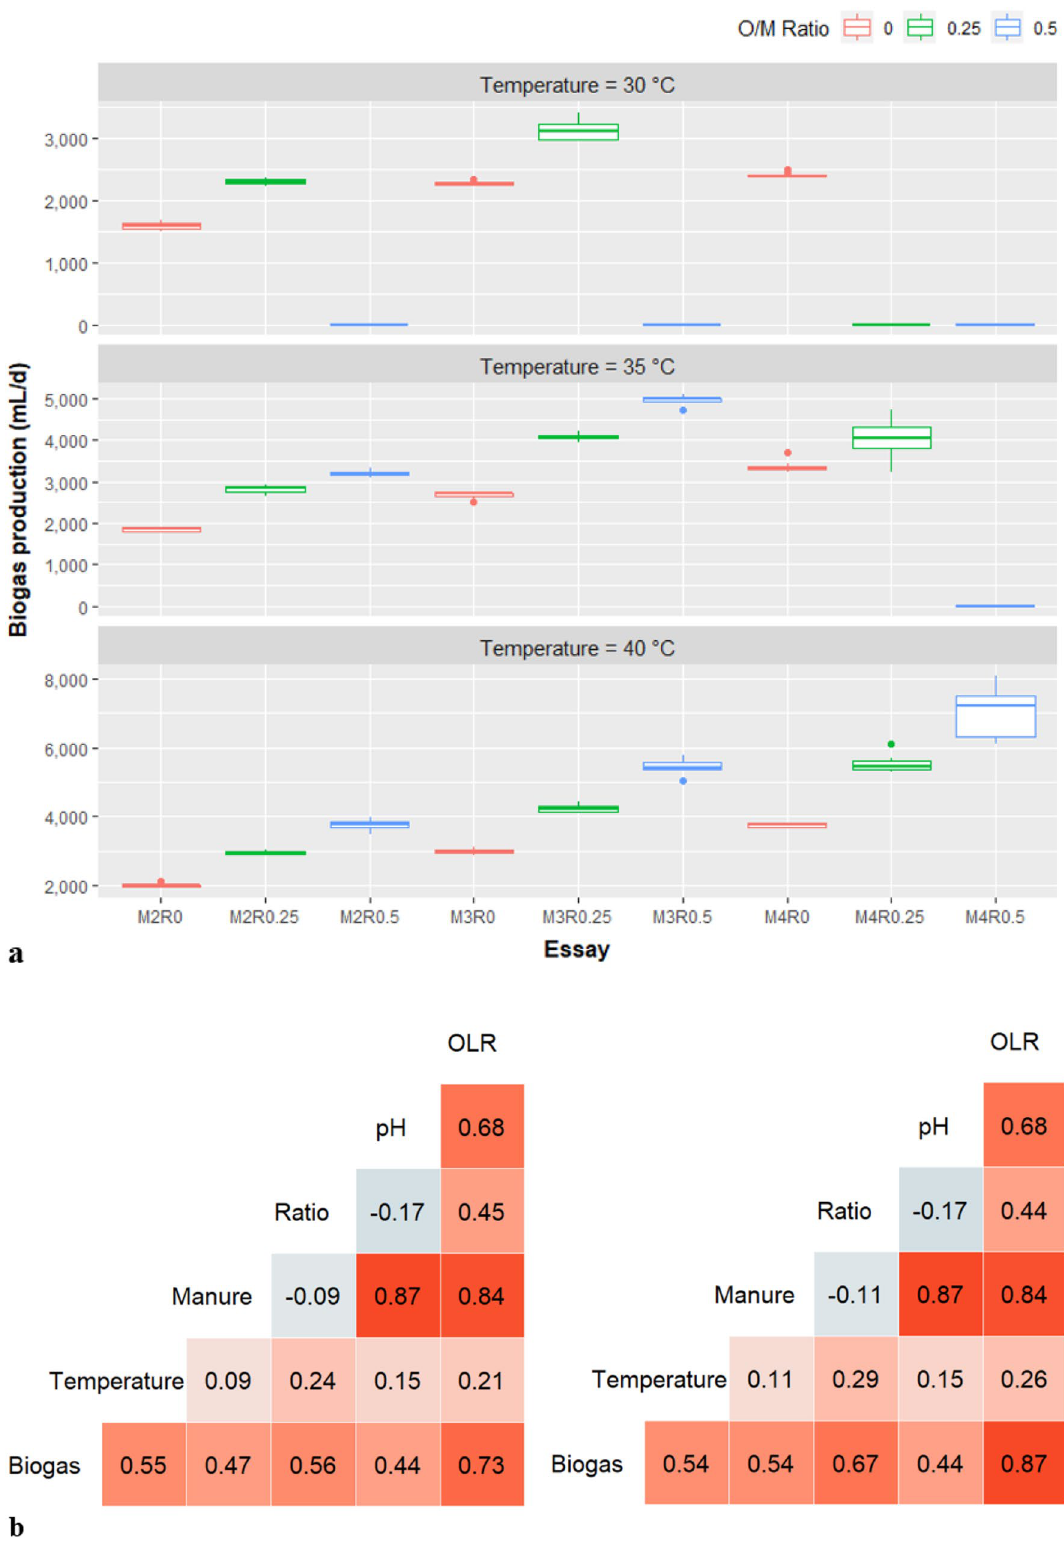
Figure 1. ( a ) Biogas production of each essay in different mesophilic temperatures and ( b ) correlation coefficients between biogas and other variables in original (left) and selected dataset (right). M2: organic loading rate (OLR) of swine manure = 2 g-VS/L/day; R0.25: VS ratio of swine manure/waste kitchen oil = 0.25; Ratio: O/M